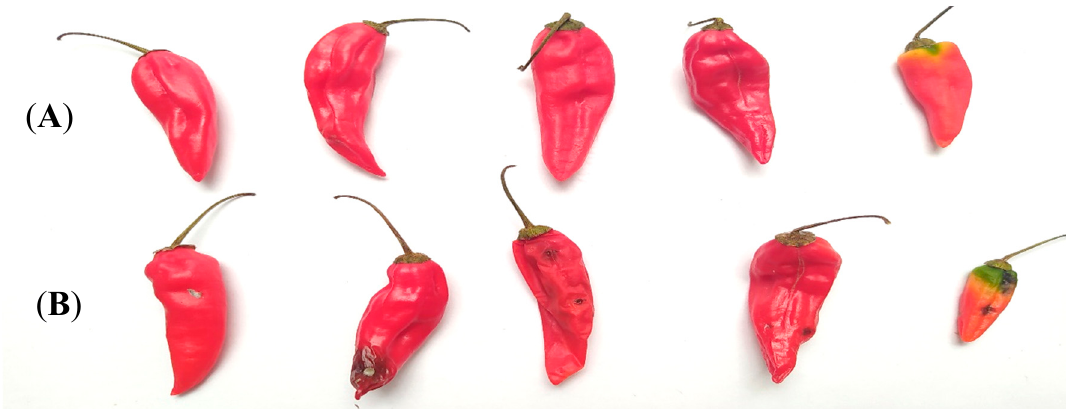
Figure 9. Difference between Topito peppers from infected plants and those treated with capsules (Chitosan-Agar-EO) of Cymbopogon citratus ( A ) and Chitosan-AGAR-Corn Oil ( B ). Controls with 20, 30, and 40 capsules of corn oil presented a percentage of damage of 84.6%, 90.2%, and 94.6%, respectively. Treatment with 20 EO capsules showed slight signs of infection with a damage percentage of 32%. Treatments with 30 and 40 EO capsules did not show any signs of